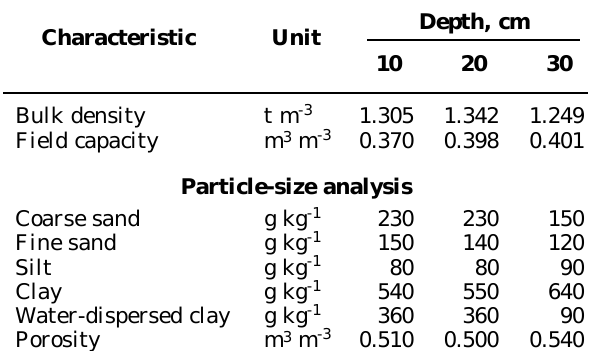
Table 2. Physical characteristics of soil at 10, 20 and